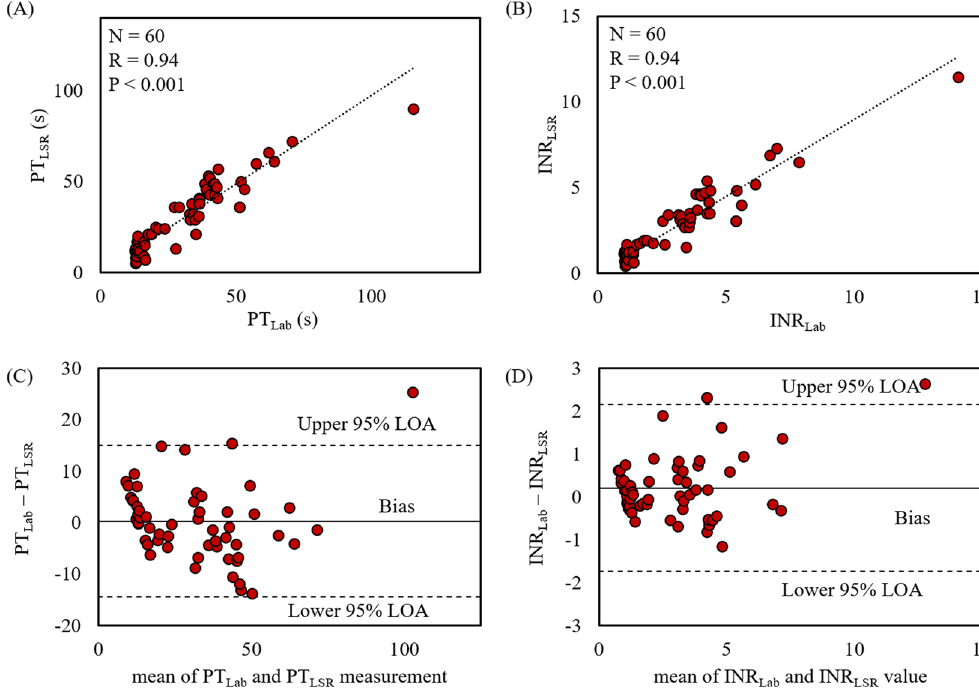
Figure 3. The plots show (A) PT and (B) INR measured using the LSR sensor against corresponding values obtained from standard laboratory tests measured from 60 patient whole blood samples. A strong statistically significant correlation between the two approaches (R = 0.94, p < 0.001) is observed. Bland-Altman plots comparing (C) PT and (D) INR measured with the LSR sensor and standard laboratory results show high concordance between both test measurements. Upper and lower dotted lines represent 95% limit of agreement (LOA) while the middle line represents bias that shows the average difference in the values measured with LSR sensor and laboratory